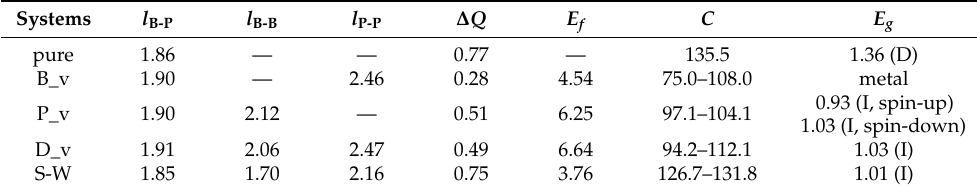
Table 1. Properties of the pure and defective boron-phosphide monolayers: average bond length (Å), Bader charge amount (average number of electrons transferred from B to P atom around the defects, unit in e ), formation energy E f (eV), in-plane Young’s modulus C (N/m), and electronic band gap E g (eV). The letters D and I in the brackets represent direct and indirect band gaps,